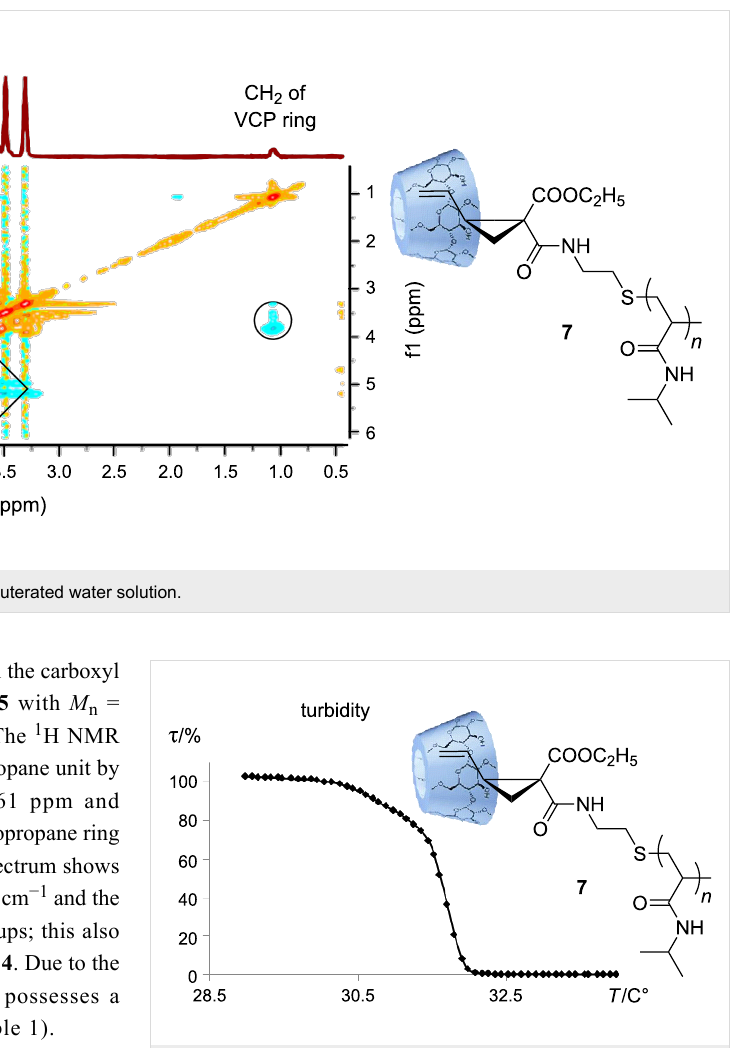
Figure 4: Temperature-dependent transparency measurements of aqueous solution of the supramolecular complex 7 ( c = 20 mg/mL in